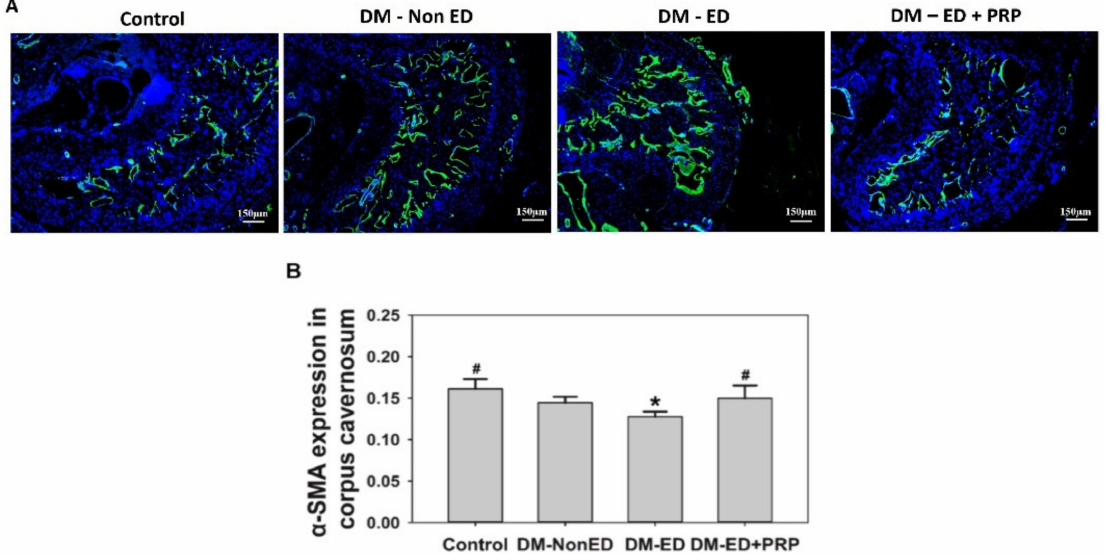
Figure 7. ( A ) Image showing the Immunofluorescence results of α -smooth muscle actin ( α -SMA); ( B ) expression of α -SMA in the corpus cavernosum. DM-non ED, streptozotocin (STZ)-induced diabetes mellitus (DM) without erectile dysfunction (ED); DM-ED, STZ-induced DM with ED and treated with saline; DM-ED + PRP, STZ-induced DM with ED and treated with platelet-rich-plasma. * p < 0.05 when compared with control, # p < 0.05 when compared with